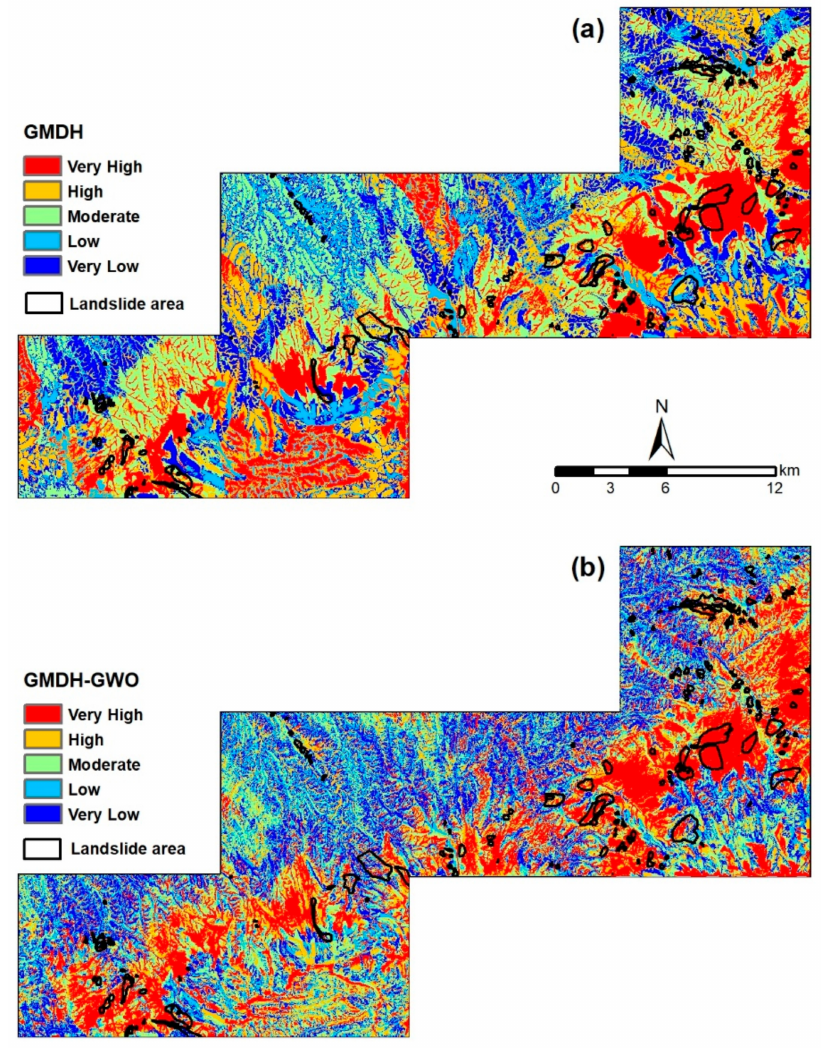
Figure 5. Landslide susceptibility map obtained using ( a ) standard group method of data handling (GMDH); ( b ) GMDH–gray wolf optimizer (GWO)